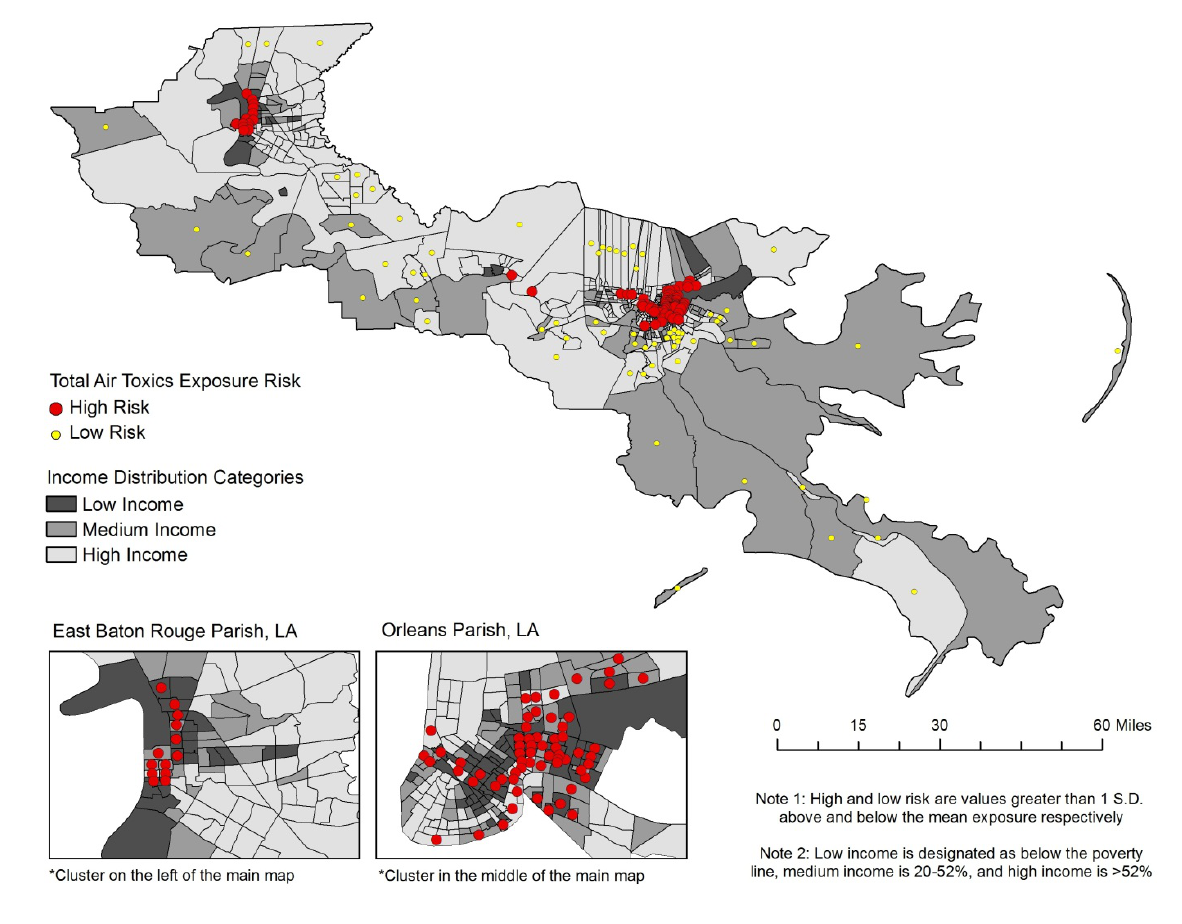
Figure 3. The cumulative risk from all toxics by income in Cancer Alley